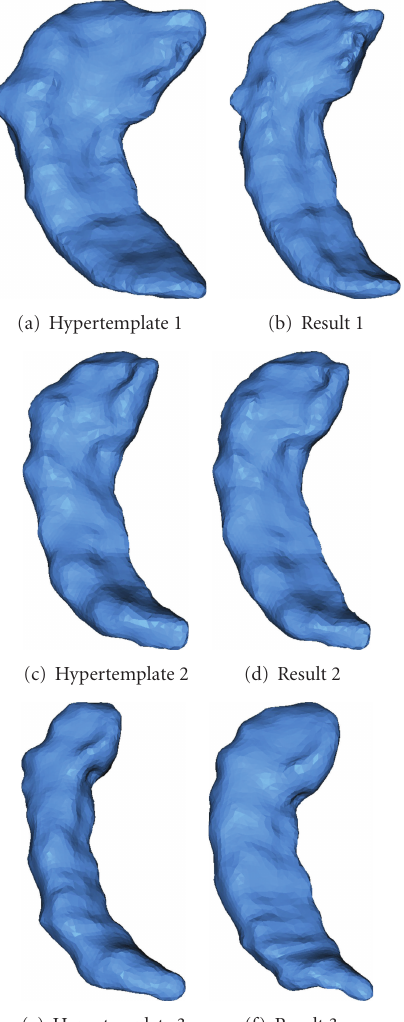
Figure 6: For the same observed population, we choose di ff erent surfaces as hypertemplate. The results only have minor di ff